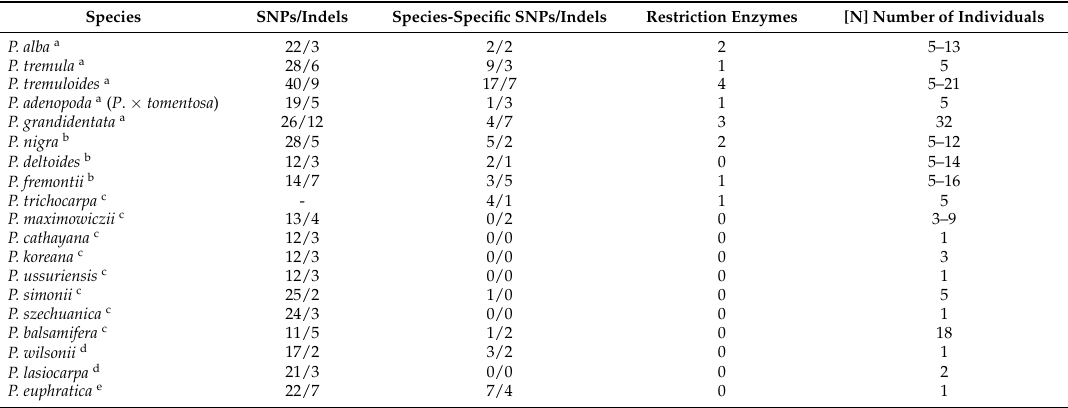
Table 2. Number of single nucleotide polymorphisms (SNPs) and insertion–deletion polymorphisms (indels) in the cp regions. Overview of the total number of found SNPs and indels, species-specific SNPs and indels, and related restrictions enzymes for the species-specific SNPs for use in PCR-RFLPs (Restriction Fragment Length Polymorphisms) in nine chloroplast regions (without psb E_ pet L). All of the nucleotide variations that were different from P. trichocarpa were counted as SNPs/indels. The number of individuals per species used for marker validation is also